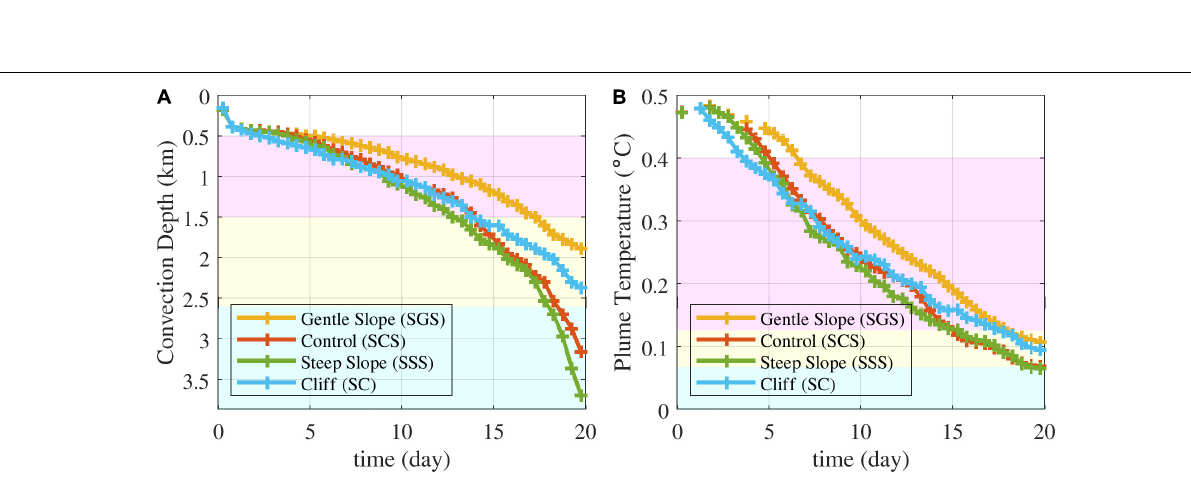
FIGURE 13 | (A) Depth and (B) potential temperature of the convective-plume head with time in several experiments (i.e., SGS, SCS, SSS, and SC) with various slope inclinations.